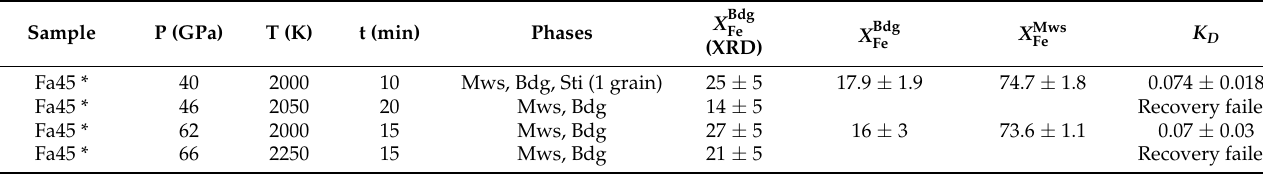
Table 1. Composition measurements by XRD and EDX and corresponding experimental conditions pressure (P), temperature (T), and duration (t). K D is defined as in the superscript phase. Uncertainties are taken from statistical error in EDX quantification. * = Laser heating and X-ray diffraction conducted at APS beamline 13-ID-D. Missing data: NR = Lattice parameters not resolvable from diffraction data, NA = No diffraction available, TS = grain sizes too small for EDX measurements. Phases: Bdg = bridgmanite, pPv = post-perovskite, Mws = magnesiowüstite, and Sti = stishovite.